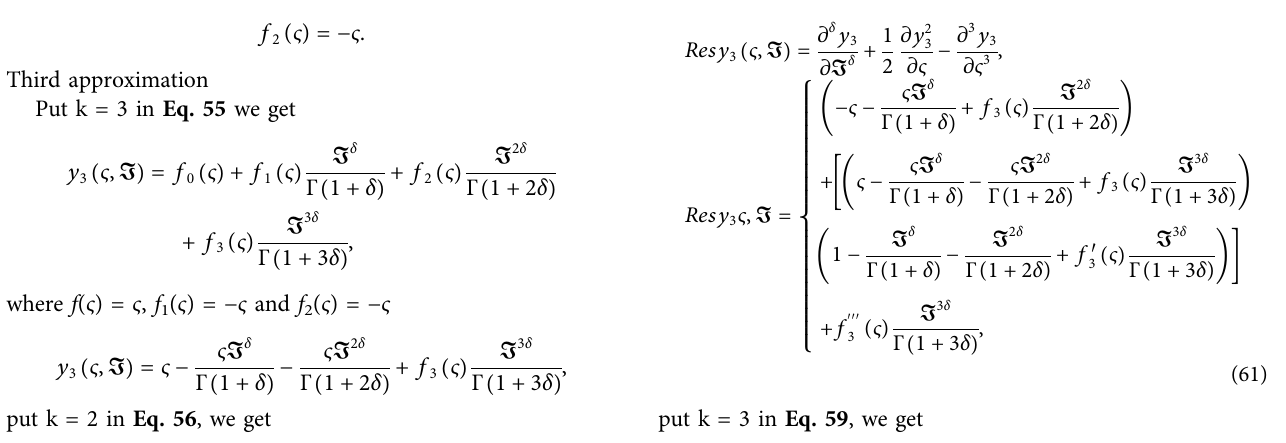
Frontiers in Physics |